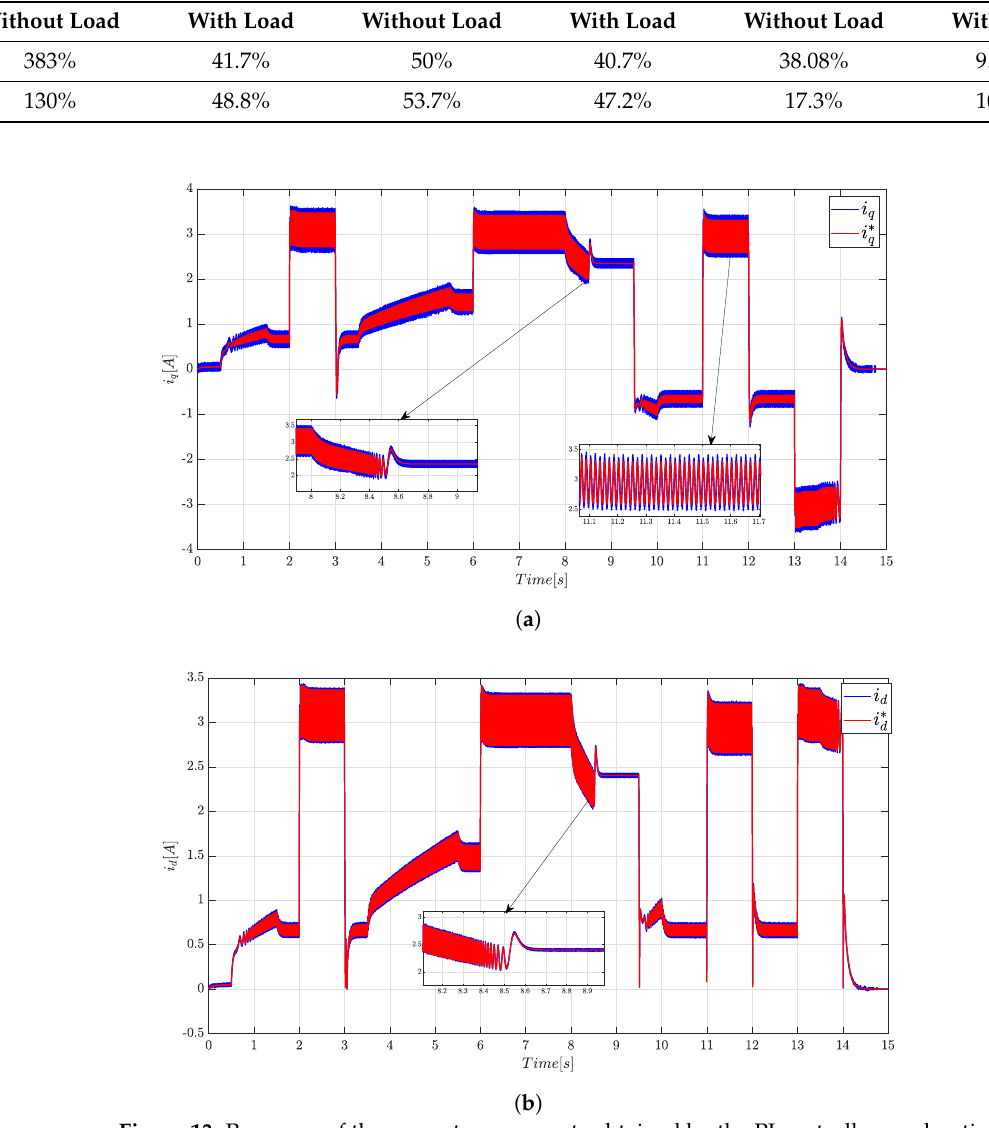
Table 1. Comparison of torque ripple rates of the three strategies FOC